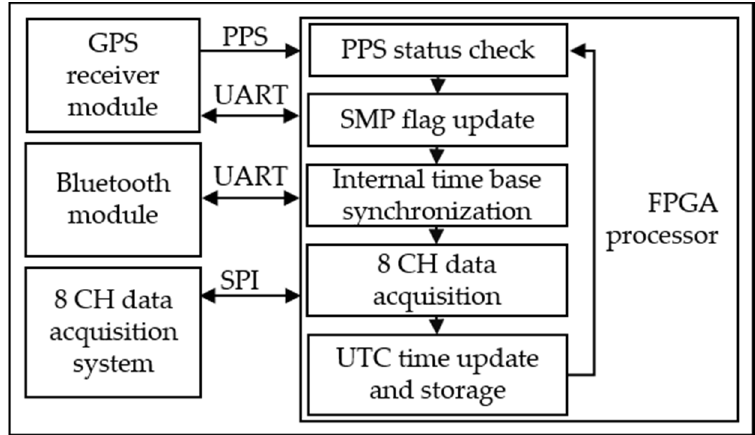
Figure 7. Proprietary data logger with GPS synchronization diagram.